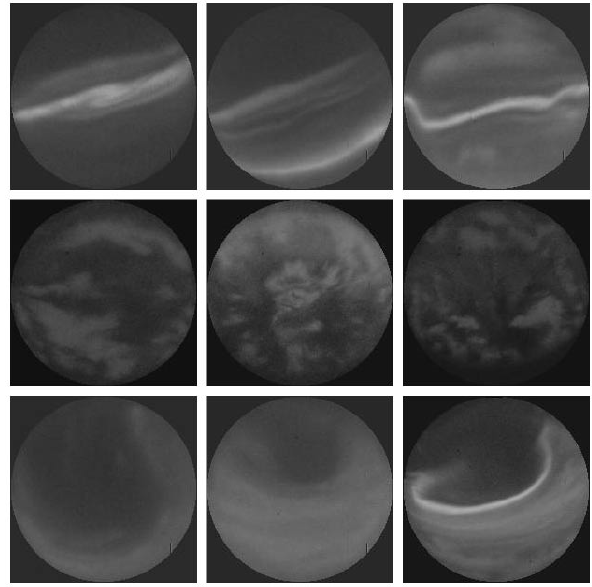
Fig. 4. Sample images from the three main auroral shape categories. Rows from top to bottom: auroral arcs, patchy auroras and Omega- bands.